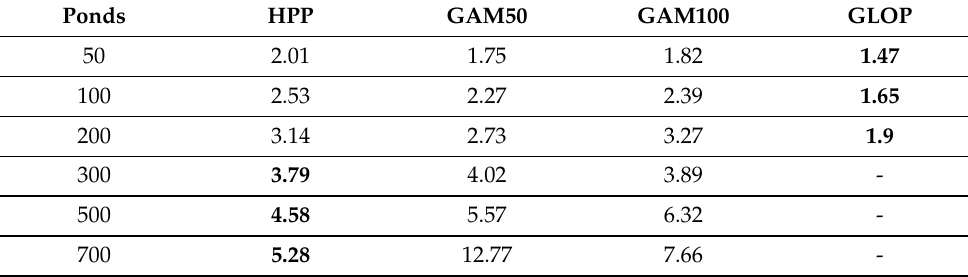
Table 2. Average Maximum Route